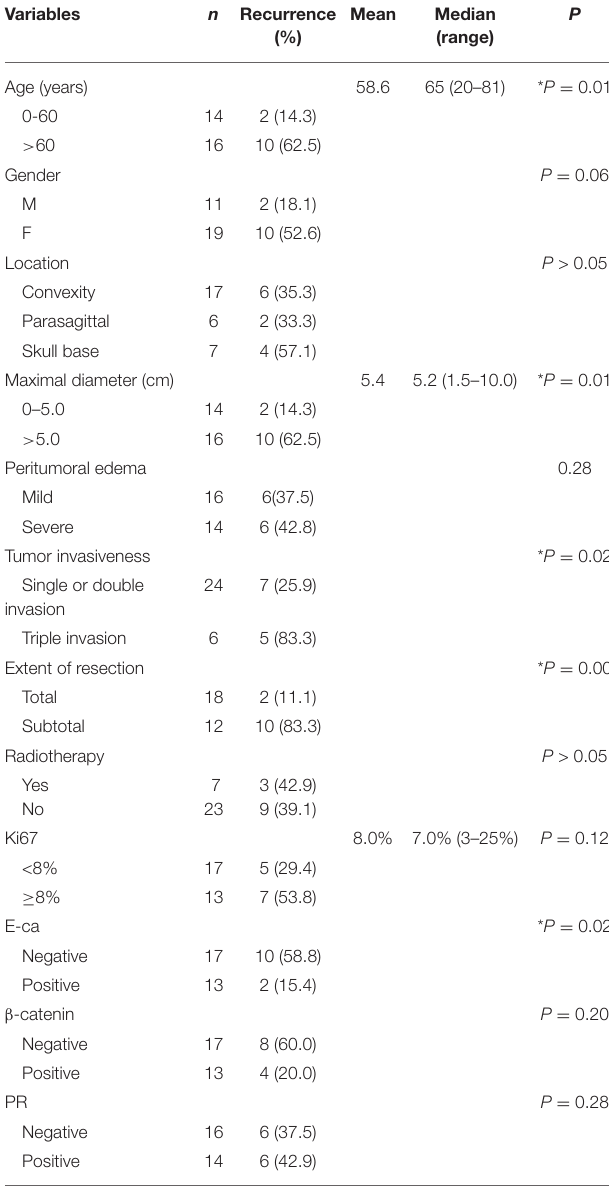
TABLE 2 | Univariate analysis of clinicopathological factors with post-operative recurrence in AM patients.